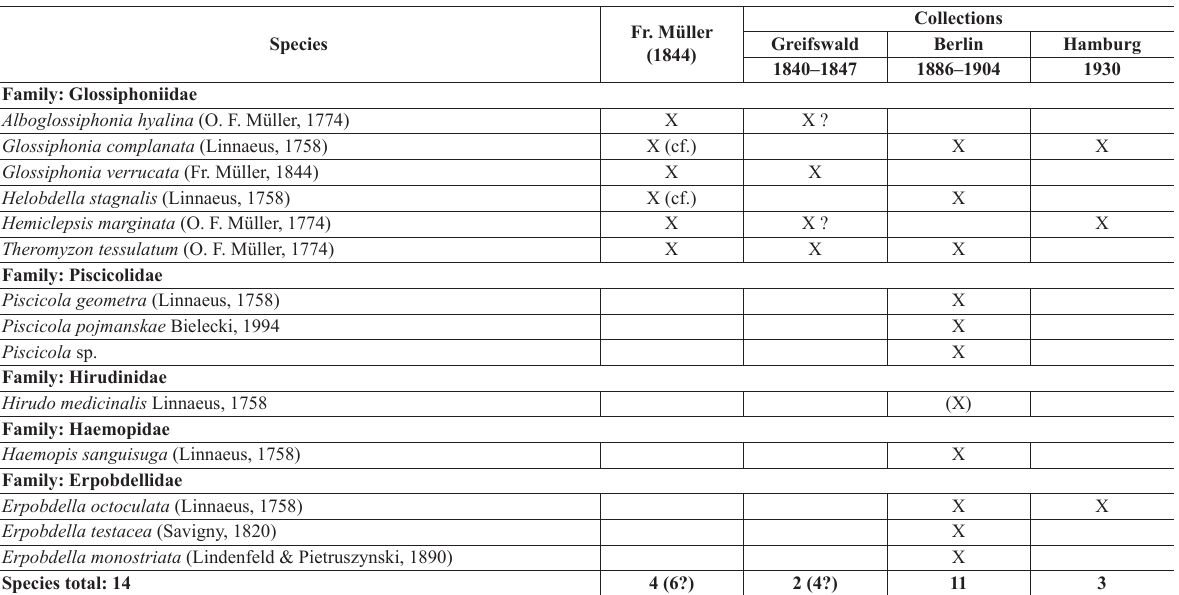
Table 2. Historical records from Lake Tegel in Berlin.